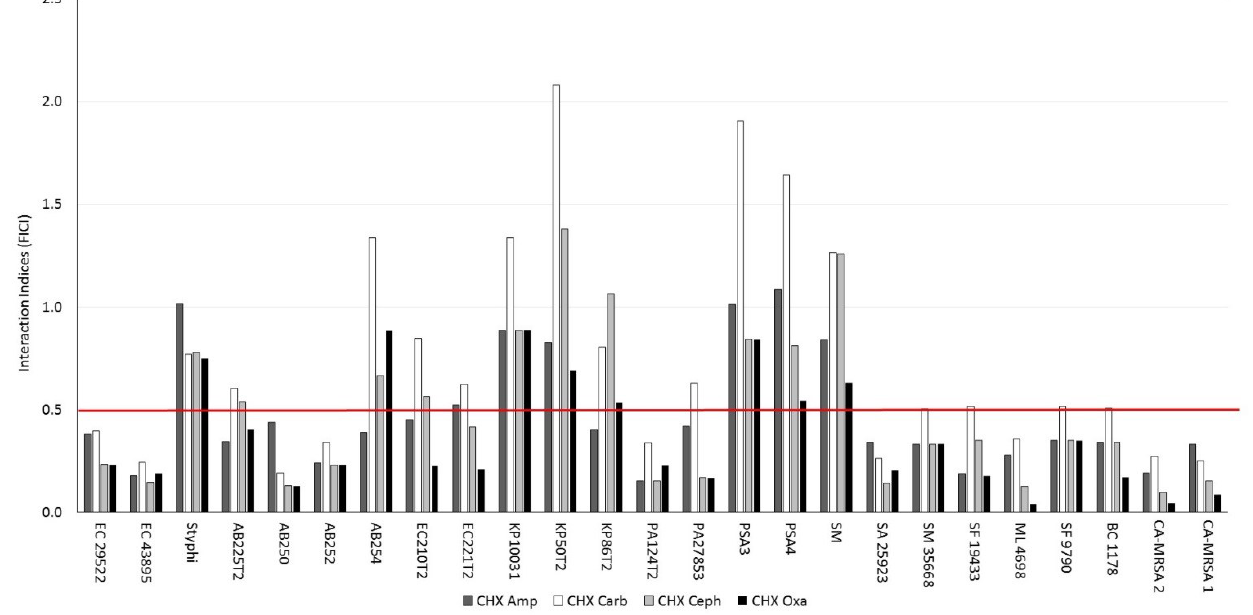
Figure 3. FICIs of β-lactam-based chlorhexidine GUMBOS determined on 17 clinical isolates of Gram-negative bacteria of varying antibiotic